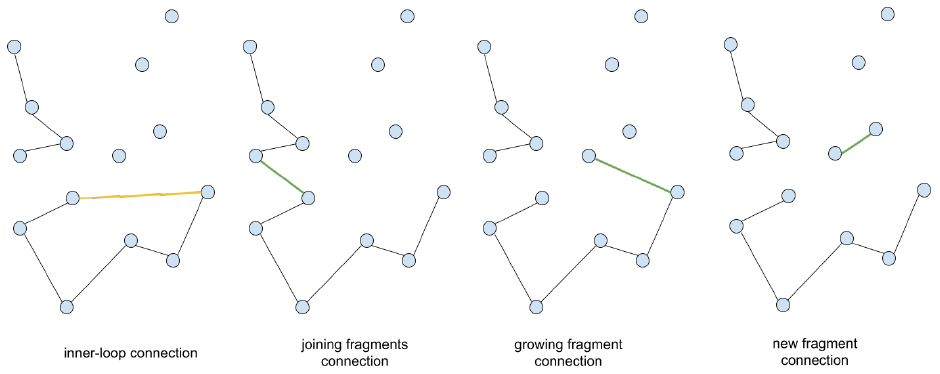
Figure A2. Events that can occur and are prevented by the tracking procedure (first two), and events that can be detected in constant time (last